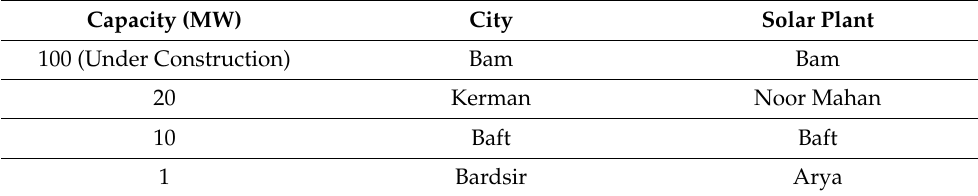
Table 2. Solar power plants in Kerman province (PV power plant). Capacity (MW) City